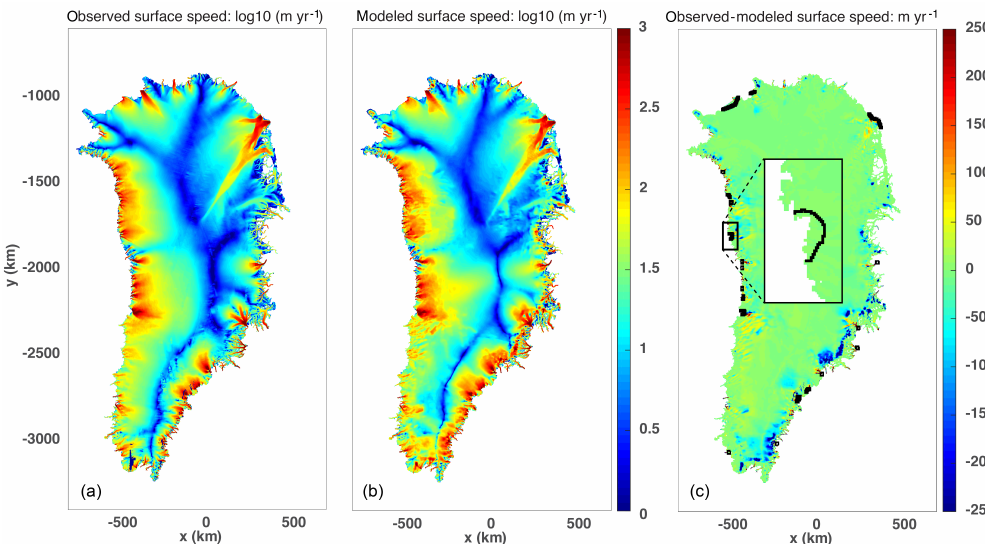
Figure 1. Observed surface speed derived from InSAR observations (Joughin et al., 2010) (left), optimized, modeled surface speed (center), and observed minus modeled surface speed (right). In the right panel, small black squares mark the locations of flux gates where Dirichlet boundary conditions on velocity are applied and the inset shows a zoom on the flux gate across the Upernavik Glacier.